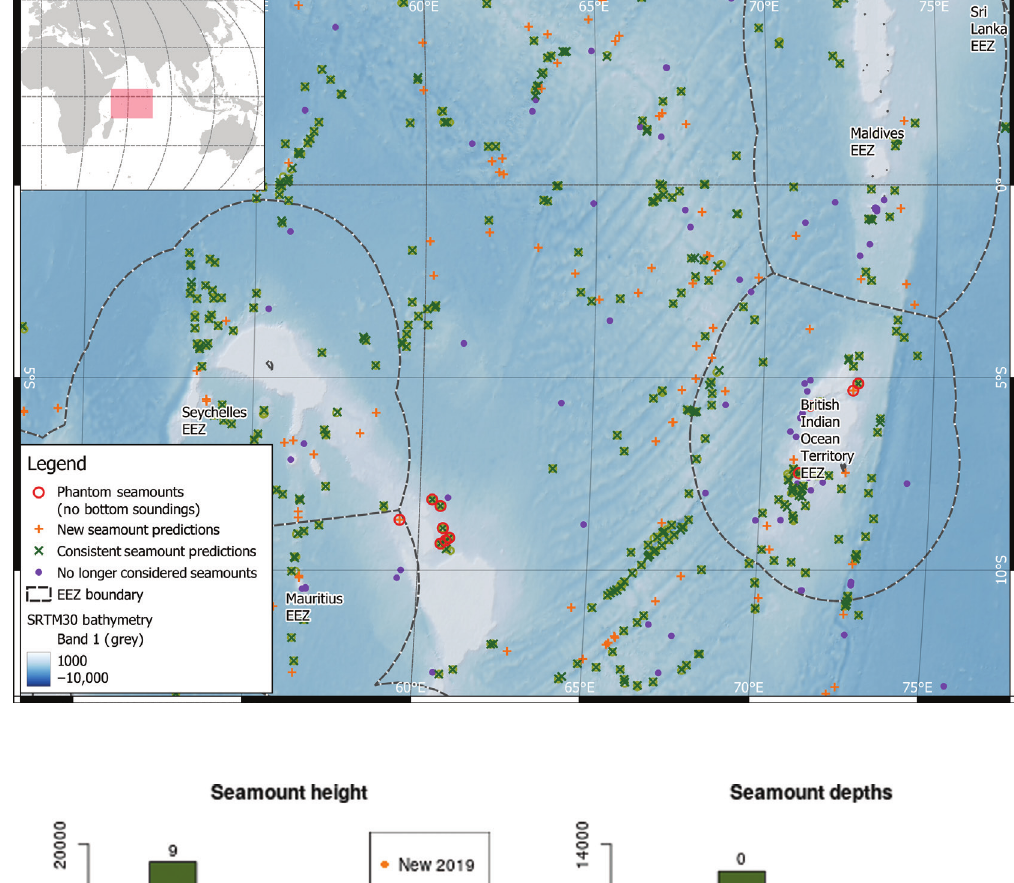
Histograms showing distribution of seamounts by seamount height (top left), depth of seamount summit (top right), and geographic location of seamount (latitude – bottom left, longitude – bottom right). Numbers above the bars show the count of ‘phantom seamounts’ in the relevant